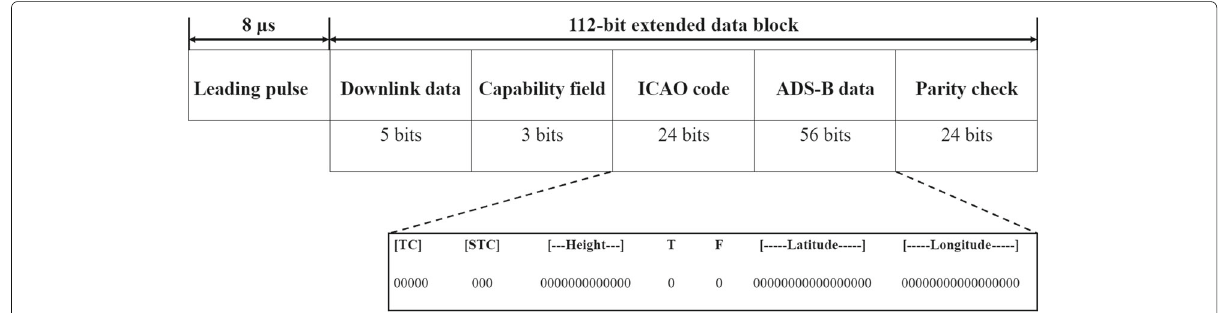
Fig. 1 ADS-B protocol with massage length of 112 bits